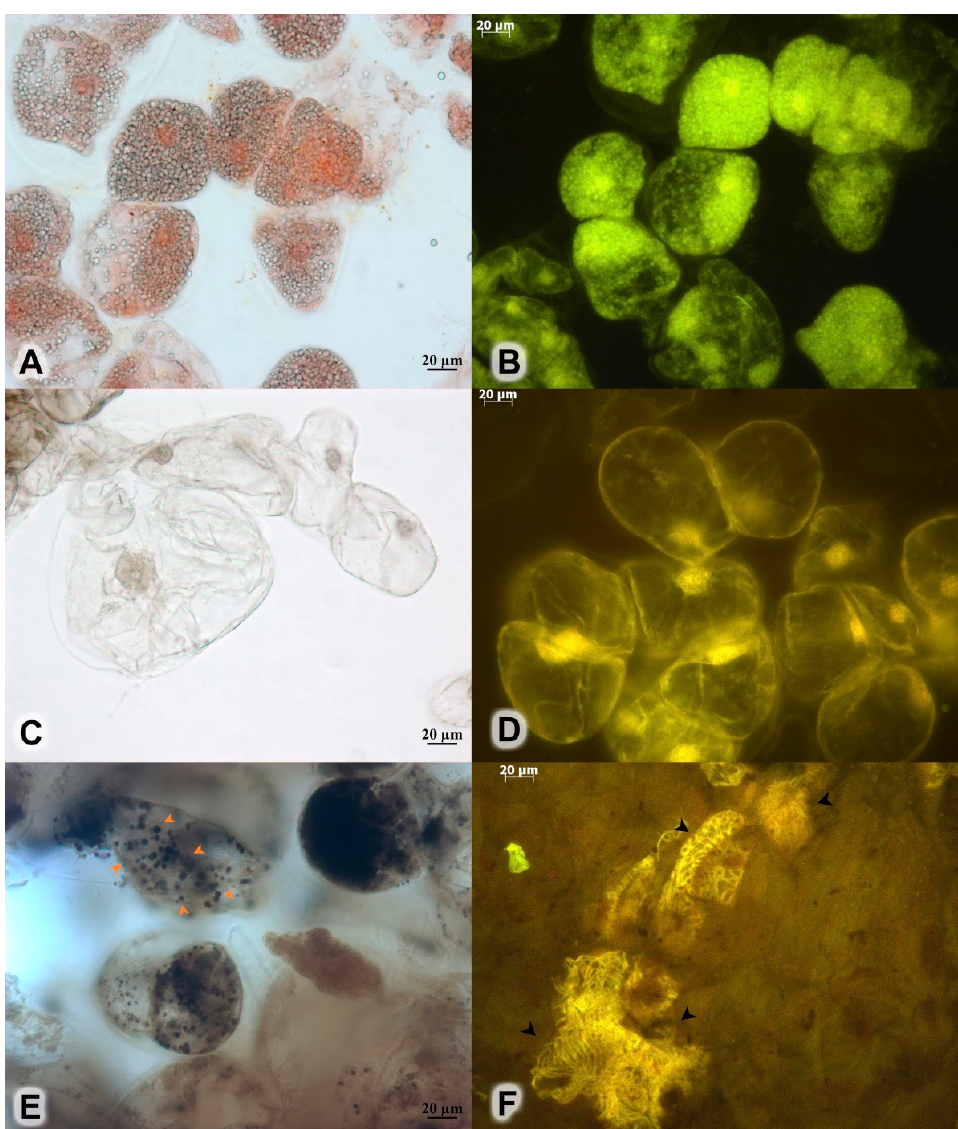
Figure 2. Callus culture of R. rosea cultivated on a modified MS medium at the NH 4+ /K + ratio of 0.33, 40 mM NO 3 − , the BAP/NAA ratio of 1.0, and concentrations of plant growth regulators at 30 μ M. ( A ) Numerous small vacuoles in immature cells seen under a light microscope and ( B ) under a fluorescence microscope. ( C ) Mature cells with a single vacuole under the light microscope and ( D ) under the fluorescence microscope. ( E ) Lugol’s solution for starch (orange arrows). ( F ) Fragments of spiral vessels as seen under the fluorescence microscope (black arrows).